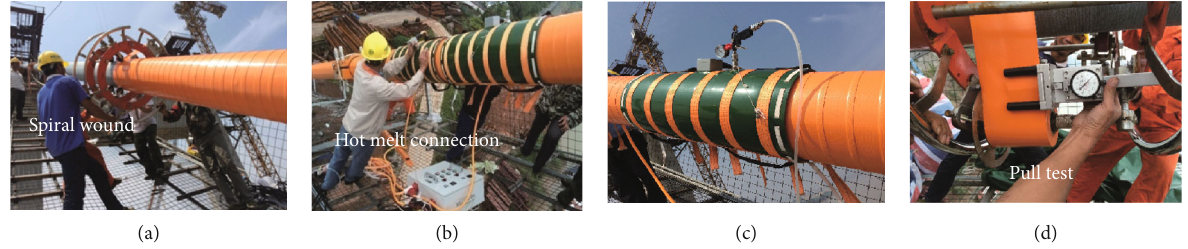
Figure 4: The construction process of winding and heating pressure vulcanization.